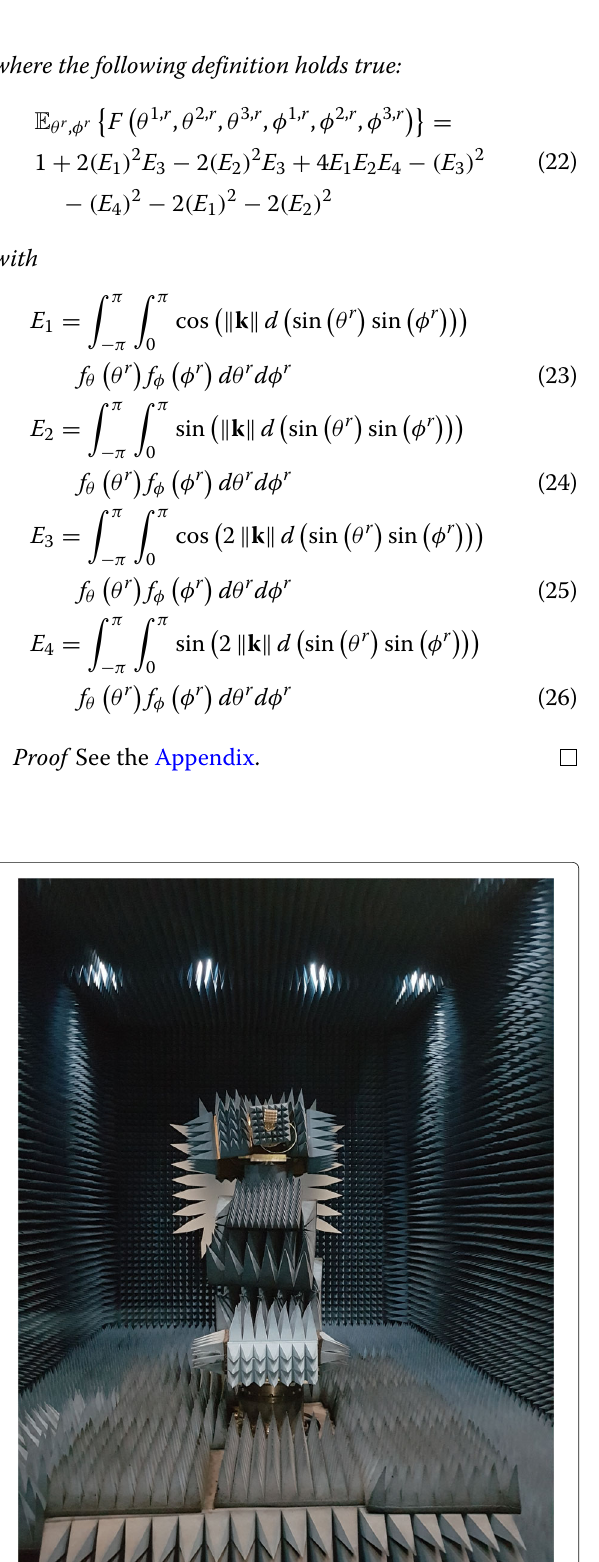
Fig. 6 Comparison of simulated (Sim) and measured (Meas) RP RP 1 . The beam cuts are measured at differently oriented angles (0 and 90 ◦ ) in space. “Co” stands for “Copolar gain,” and “XP” stands for “Cross Polar